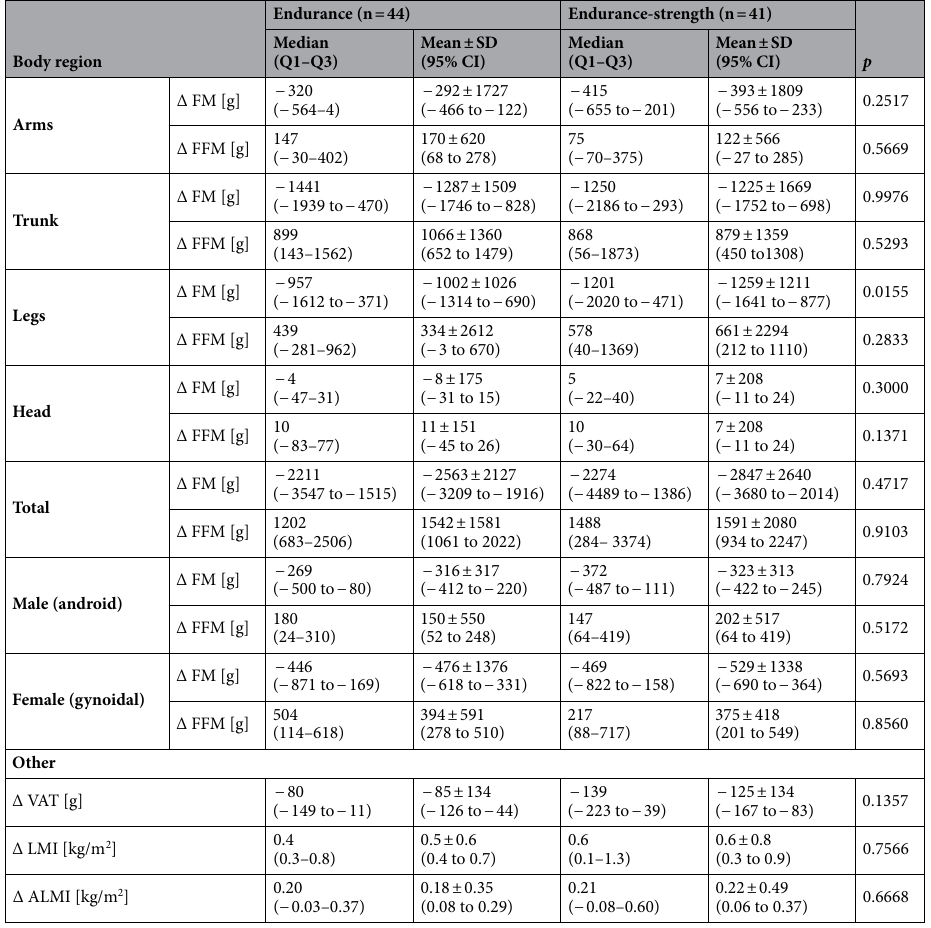
Table 5. Comparison of the mean difference of changes in anthropometric parameters and body composition between endurance and endurance − strength training using the ANCOVA test, adjusted for the baseline measures as a covariate. ALMI appendicular lean mass index, FFM free fat mass, FM fat mass, LMI lean mass index, VAT visceral adipose